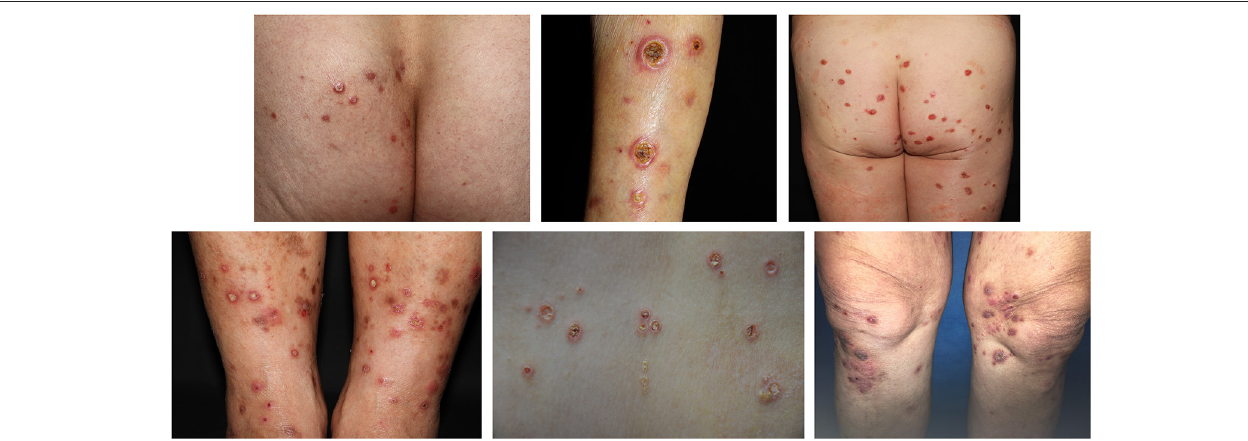
FIGURE 1 | The clinical presentation of an APD patient. Skin lesions were widely distributed all over the trunk and limbs, the main manifestations were keratinized purplish-red papules or ulcers, about rice to bean size. The center of most papules was navel concave, the surface was a yellow adhesive exfoliated scab shell surrounded by a purplish-red halo. The edge of the ulcer was levee shaped and palpated with moderate hardness.